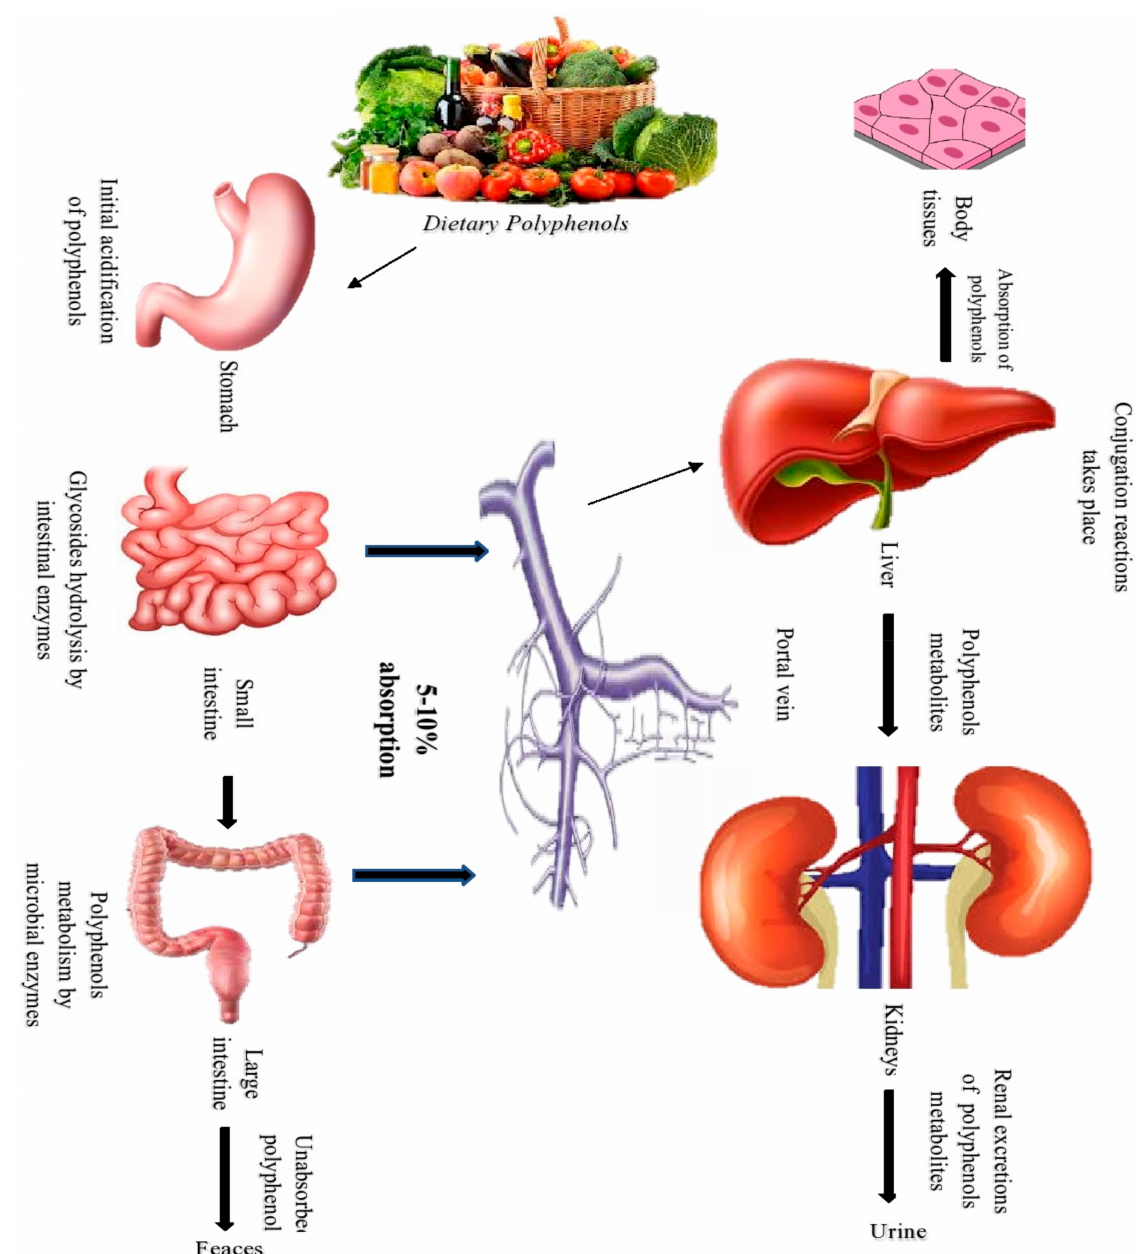
Figure 1. A sketch shows the bioavailability of